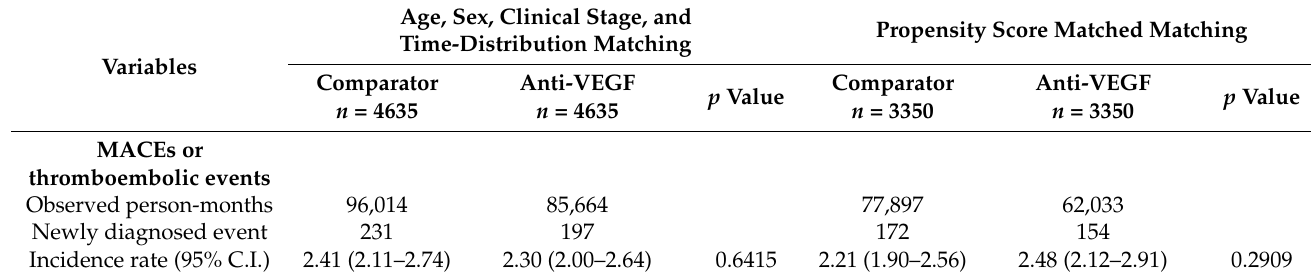
Table 2. The risk of MACEs, thromboembolic events, and all-cause mortality among time-distribution matched groups and propensity score matched